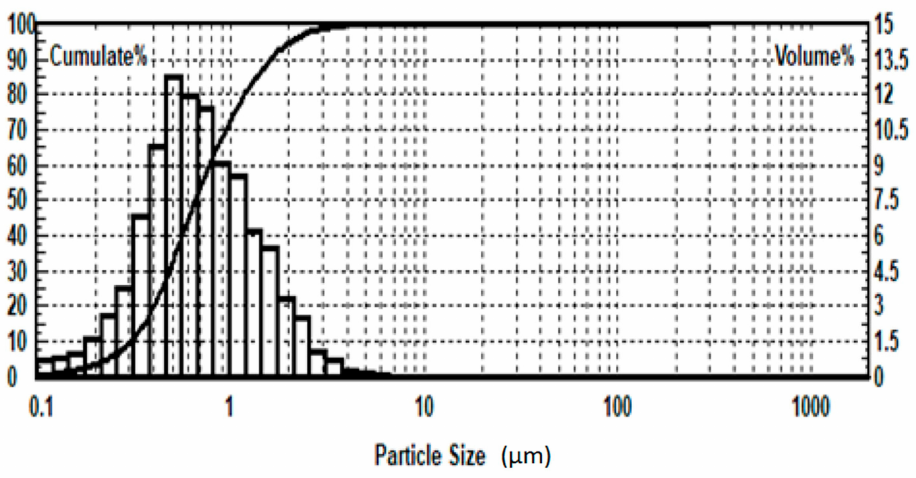
Figure 8. Distribution of particles in the combined collector agent after